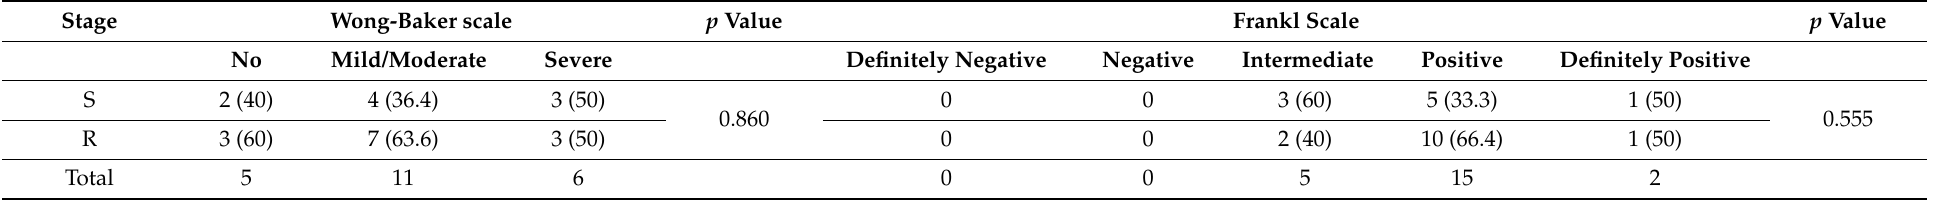
Table 3. Pain perception and attitude [ n (%)] using Wong–Baker and Frankl scales, respectively, in the different evolutionary root resorption stages and corresponding p values.